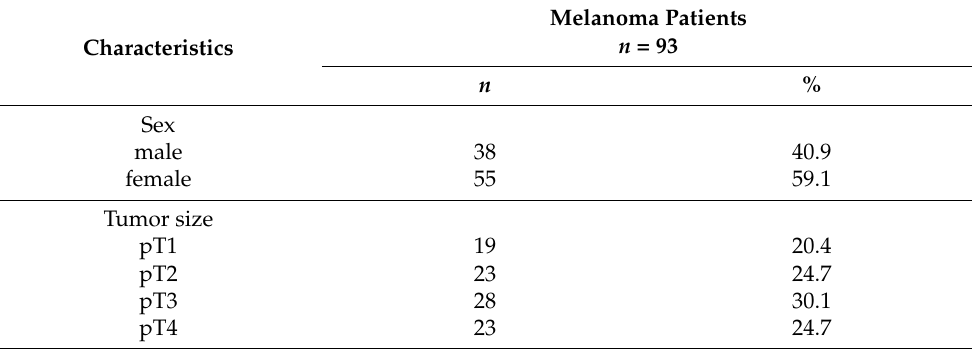
Table 1. Clinical and histopathological characteristics of melanoma patients. Sex, tumor size (T stage), involvement of lymph nodes (n stage), distant metastases (M stage), the presence of ulceration, and subtype classification are indicated for the included melanoma patients. SSM—superficial spread- ing melanoma, LMM—lentigo maligna melanoma, ALM—acral lentiginous melanoma, NMM— nodular